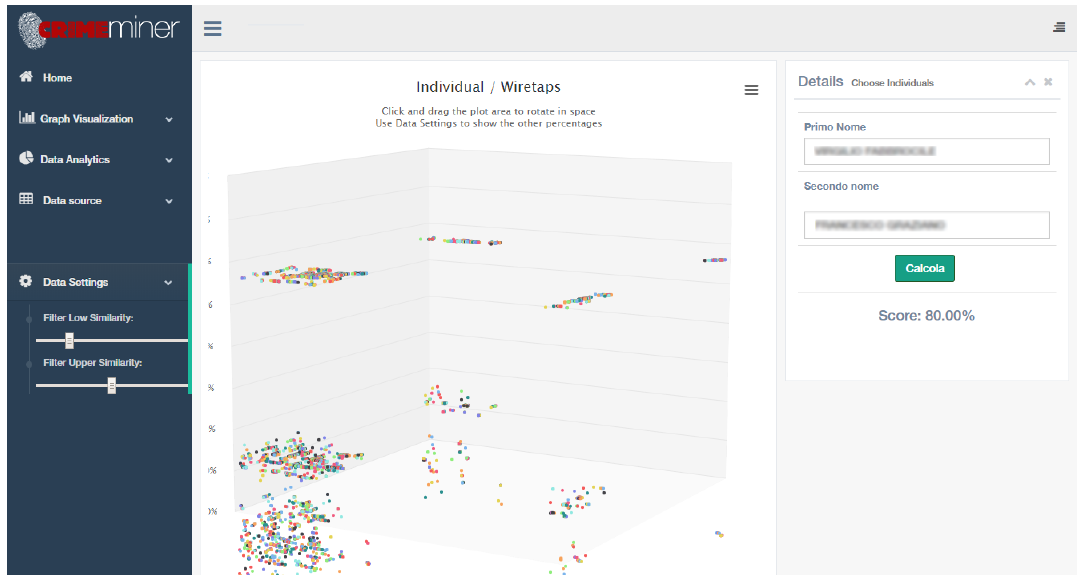
Figure 6. Similarity charts among all individuals in the network. On x and z axes are the individuals’ names and on y axis is the similarity percentage between each pair of individuals.